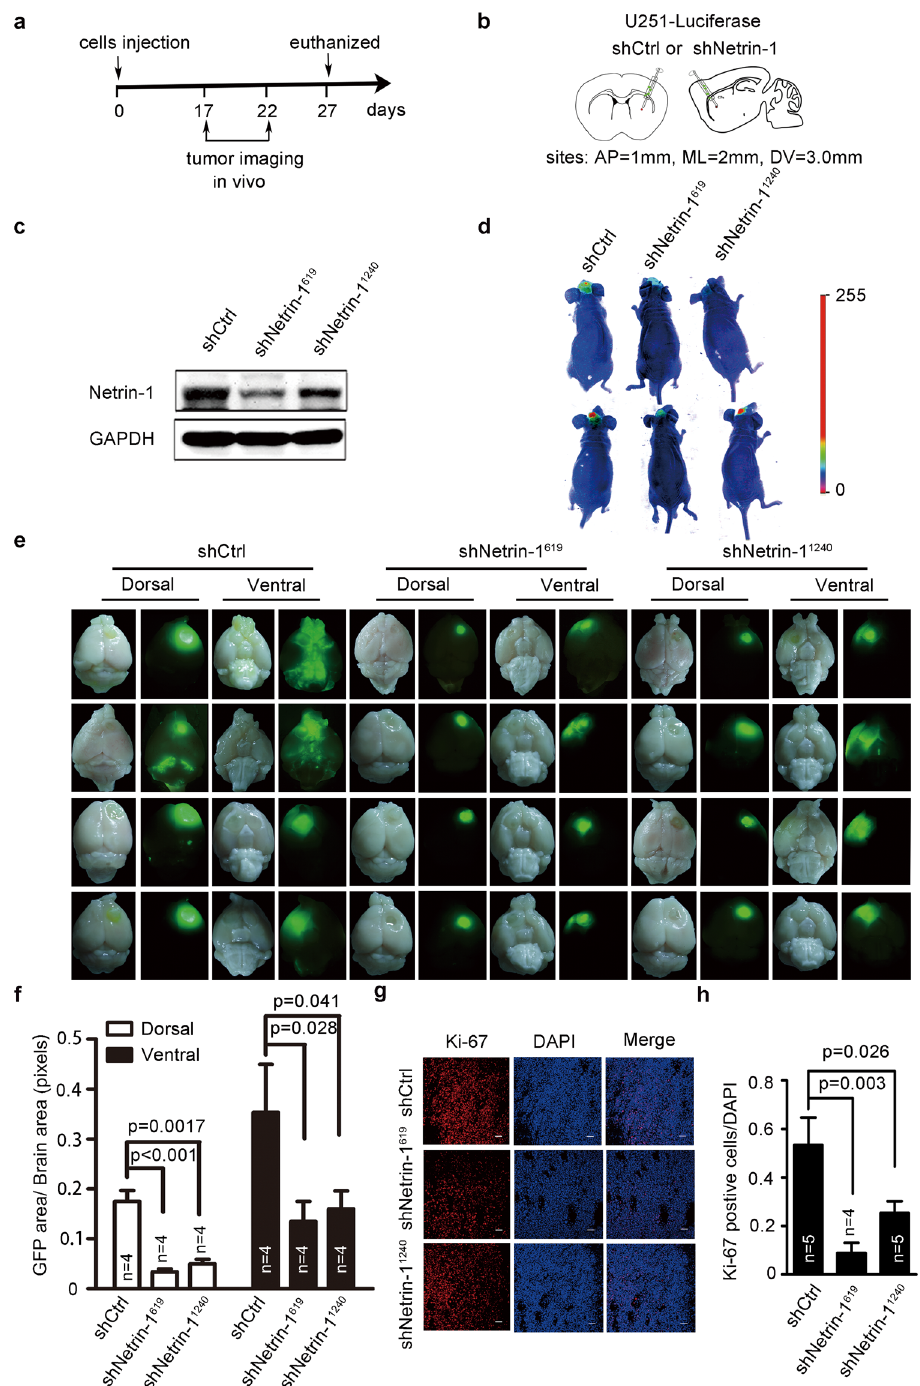
Figure 4. Netrin-1 silencing inhibited glioma growth in vivo . ( a ) A schematic diagram of netrin-1 administration. ( b ) A schematic illustration of the injection sites. The red points indicate the injected sites. AP: anterior-posterior of the bregma; ML: medial-lateral of the bregma; DV: dorsal-ventral of the dura. ( c ) Western blotting analyses of netrin-1 expression in U251 cells stably expressing luciferase, Netrin-1 shRNA or control shRNA. ( d ) Images of luciferase signal in tumor-bearing mice visualized by administration of D-Luciferin (15 mg /mL, 200 µ l/20 g) potassium salt via intraperitoneal injection. ( e ) Comparison of brain tumor growth in male BALB/c nude mice at the 27 th day after implantation of U251 cells infected with lentivirus encoding luciferase together with Netrin-1 shRNA or control shRNA. Dorsal and ventral views of the brain tumors initiated by U251 in vivo (n = 4 for each group). ( f ) Quantification of the area of EGFP across the dorsal and ventral brain regions of mice after implantation using Image J software (n = 4 for each group). ( g ) Representative images of Ki-67 staining in U251-derived tumor sections. Scale bar: 50 µ m. ( h ) Quantification of Ki-67-positive cells in the three groups (n = 4 for each group). Error bars represent the mean ±